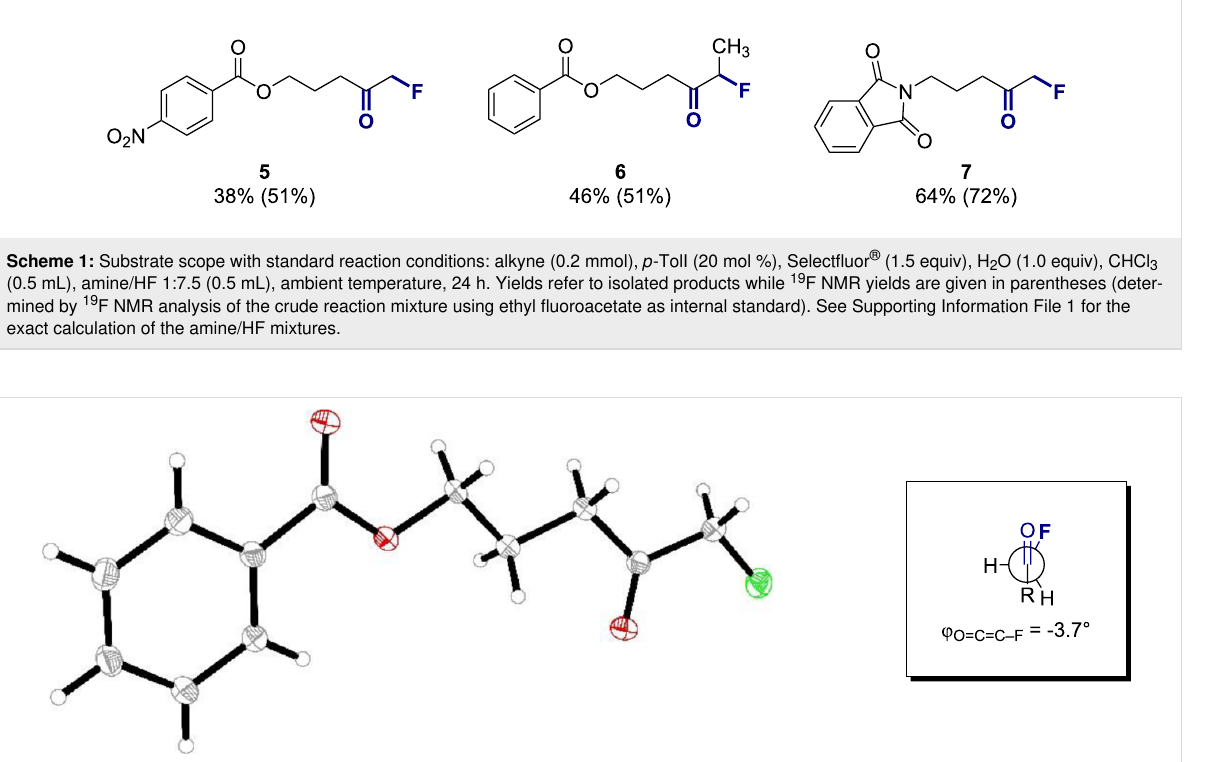
(Figure 3C). Similar yields were observed when comparing the stoichiometric reaction and the catalytic process using an amine/HF ratio of